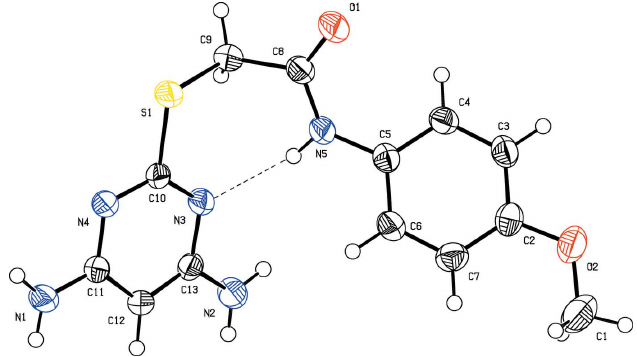
Figure 1 The molecular structure of the title compound, showing the atom